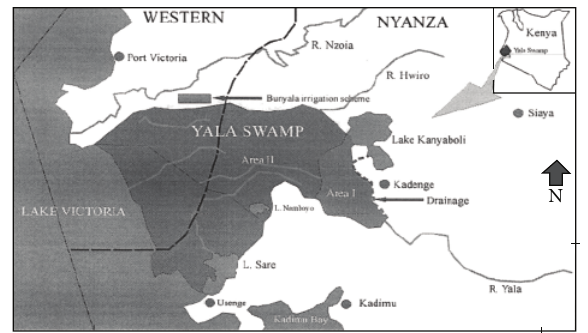
Figure 1: Map of Kanyaboli village